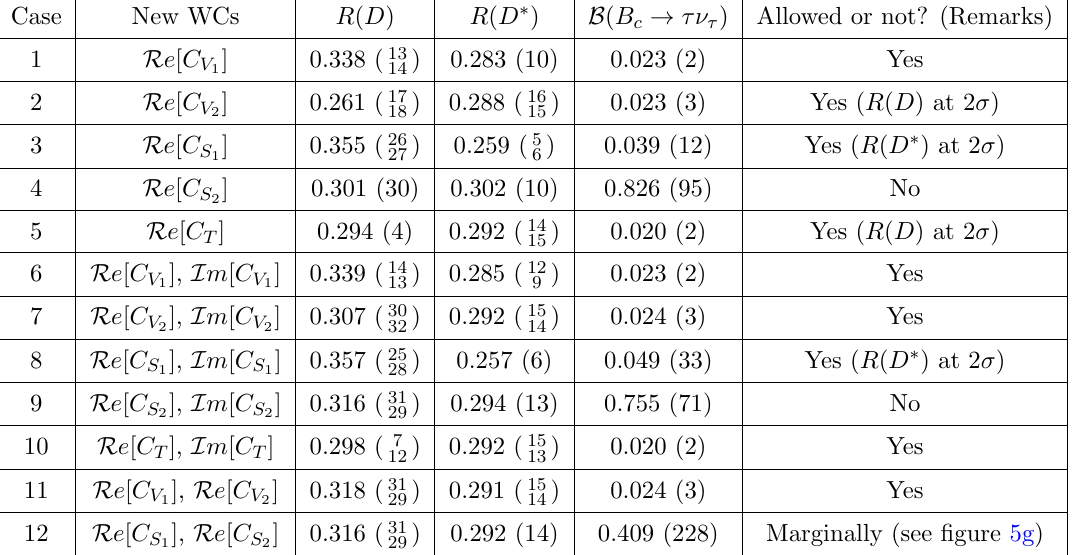
Table 9. R ( D ( (cid:3) ) ) predictions for the di(cid:11)erent new physics scenarios using the (cid:12)t to all experimental inputs (in table 7) except the ones from BaBar. The cases with B ( B c ! (cid:28)(cid:23) (cid:28) ) > 30% are physically ruled